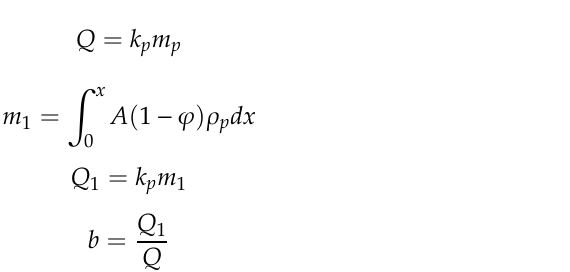
Figure 10. The sum of frictional energy and plastic deformation energy.